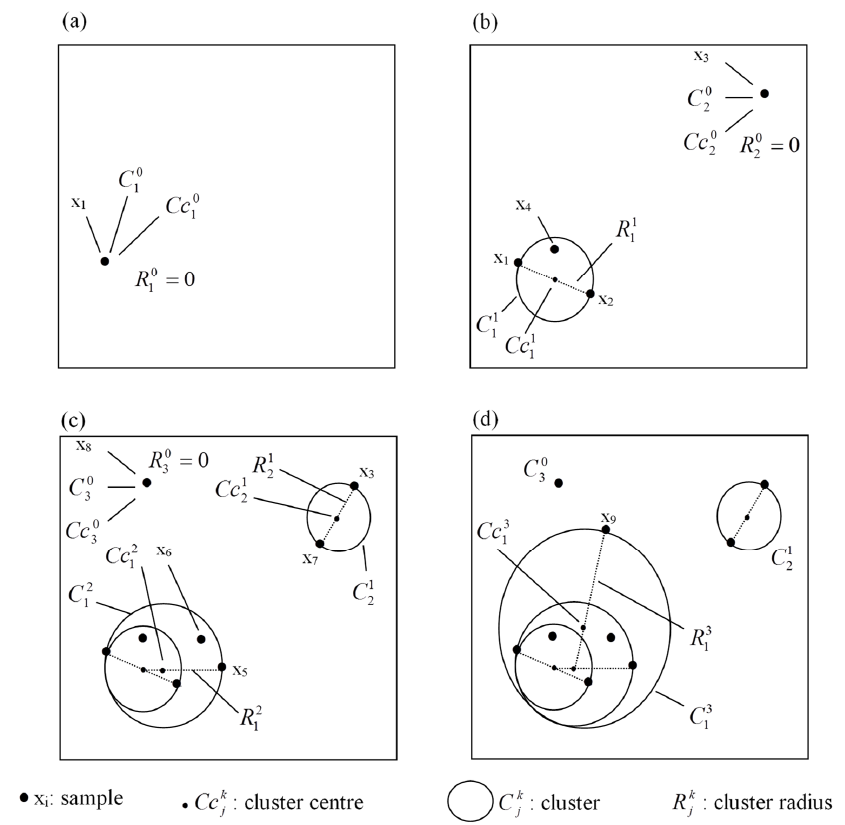
Figure 4. Schematic mechanism of the Evolving Clustering Method (ECM) using the samples x 1 to x 9 in a 2-D space (adopted from Kasabov and Song [32]).